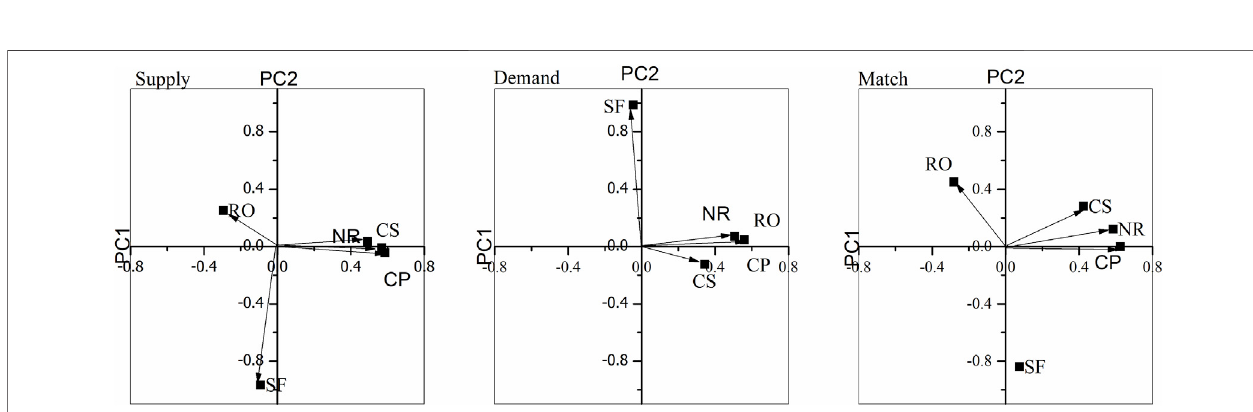
FIGURE 5 | Principal component analysis result among ESs at three sides of supply, demand, and match degree.